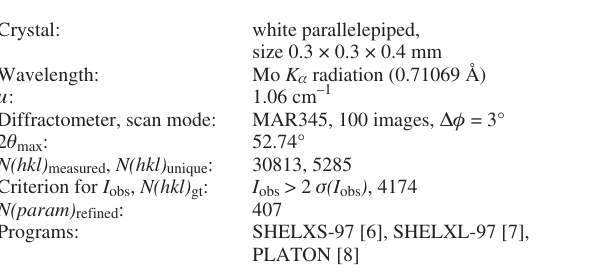
Table 1. Data collection and